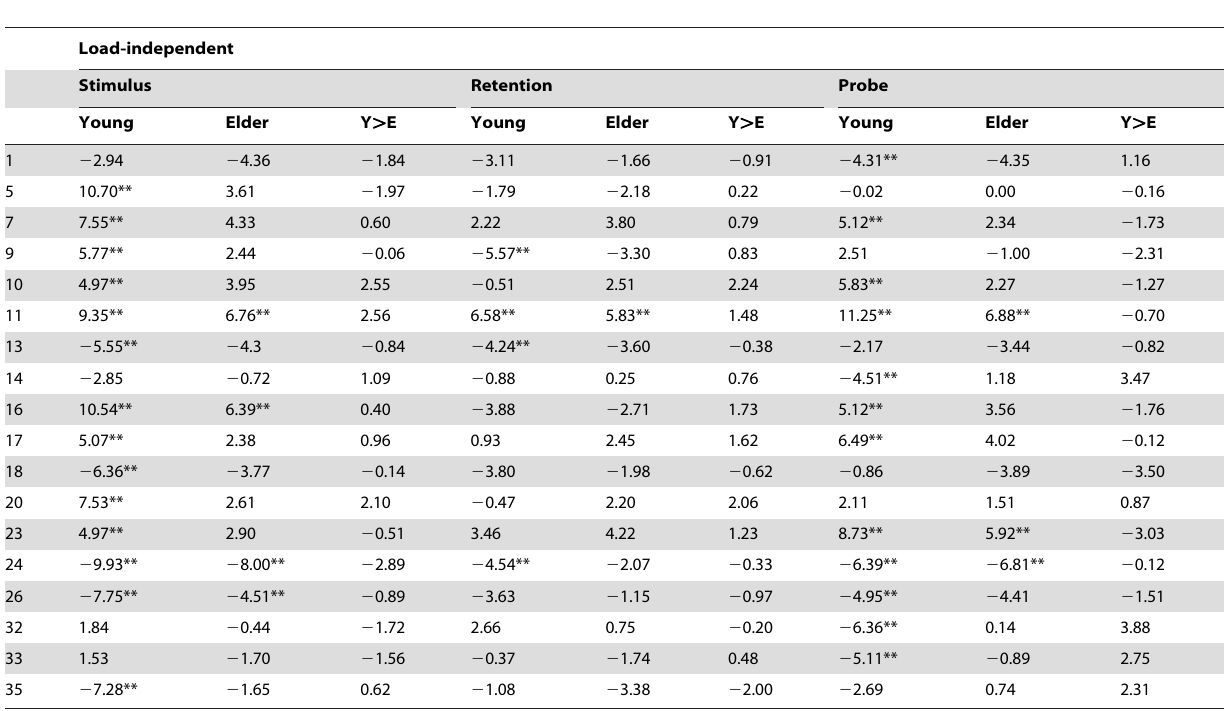
Table 3. Within and between age group comparisons of the individual time-course of each component and the load independent contrasts for each task